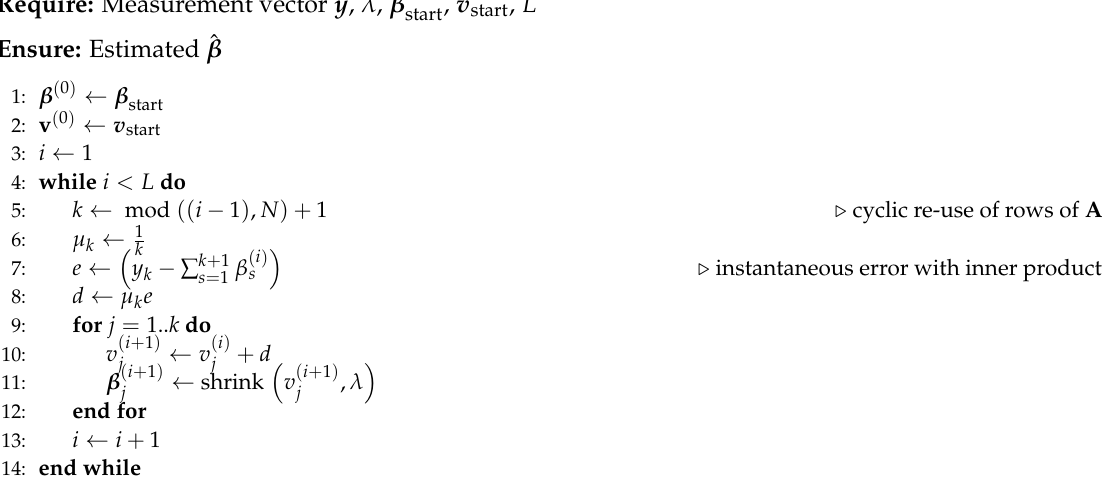
Algorithm 1 Linearized Bregman iteration for trend break